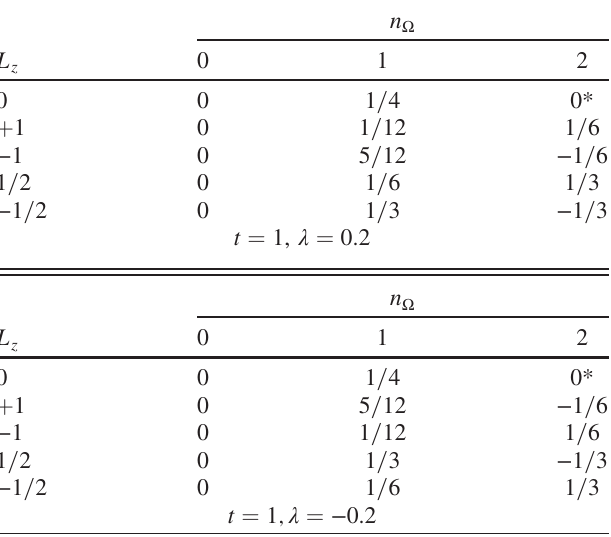
TABLE I. Haldane model disclination charge with zero mag- netic flux. Here we also include examples of half-integer L they are physically